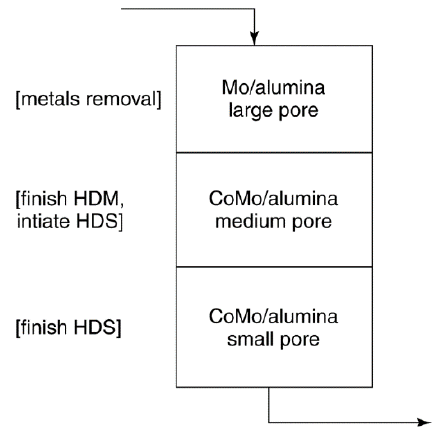
Figure 33. Staged reactor system with decreasing pore size strategy for hydrodemetalization (HDM)/hydrodesulfurization (HDS) of residuum. Reproduced